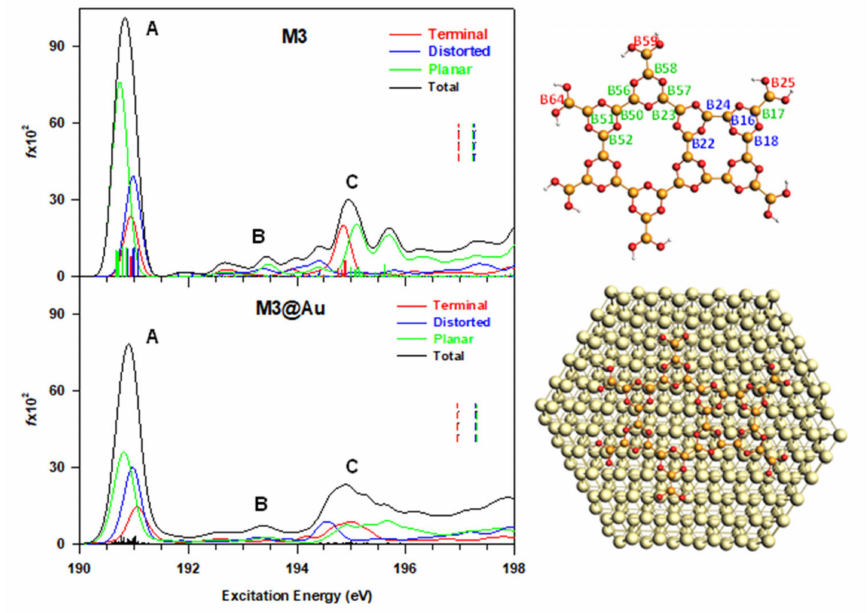
Figure 4. Comparison between the calculated B1s NEXAFS spectra of free M3 ( upper panel ) and M3@Au(111) ( lower panel ). The contributions of the three groups of non-equivalent B i sites are also shown (colored solid lines). The ∆ SCF B1s ionization energies are shown as vertical dashed lines (the IP values are reported in Supplementary Table S1). The stick spectra are broadened by using a Gaussian line shape with FWHM = 0.3 eV. The M3 and M3@Au(111) models employed are reported on the right